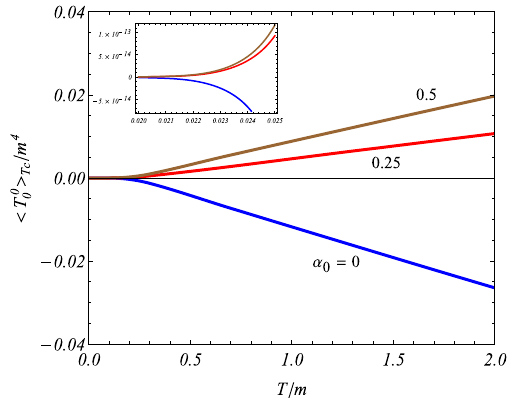
Fig. 5 The energy density contribution induced by the compactifica- tion is plotted for D = 3 as a function of the ratio T / m , with fixed parameters q = 2 . 5, mr = 1, L / m = 1, | ˜ μ | / m = 0 . 5, ˜ η = 0 . 5 and ξ = 0. The numbers near the curves represent the different values of α